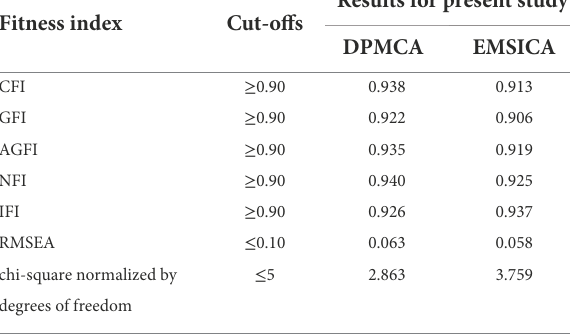
TABLE 6 Results from estimation of fitness indices for the structural